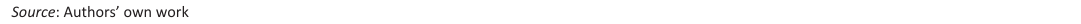
FIGURE 2: Forest plot of the effect of strengthening exercise versus no therapeutic exercise (control) in improving pain measured at 12 months. could be because of the large discrepancy in the study sample sizes, shifting the weighting of the overall effect. The overall effect shows that strengthening exercise can have a significant effect on pain reduction for up to 12 months after the intervention is